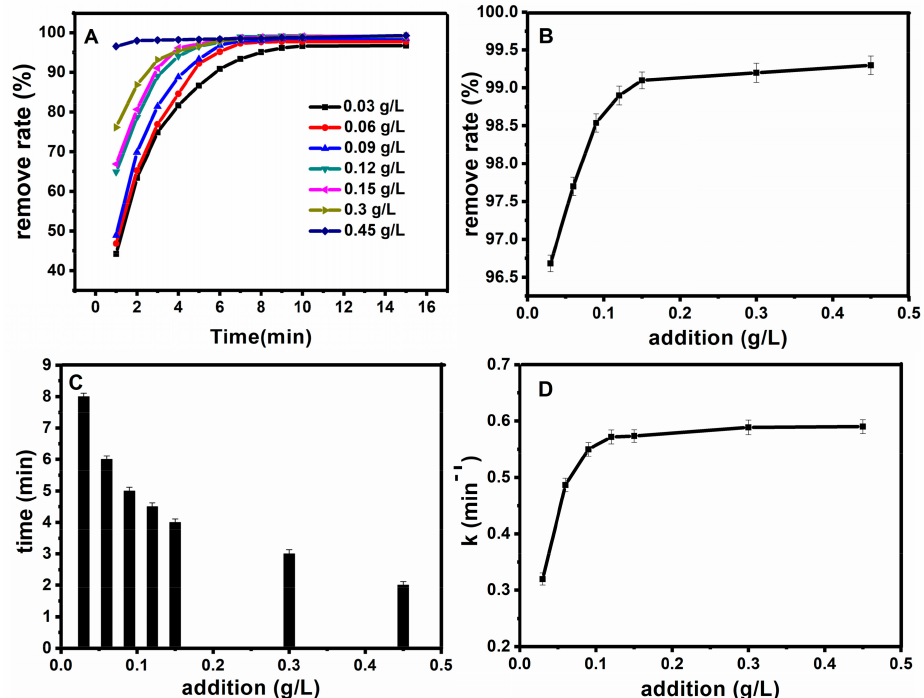
Figure 8. Effect of catalyst dosage on oxidation rate ( A ); the relationship between the catalyst dosage and the removal degree after half an hour ( B ); the relationship between the catalyst dosage and time when the removal degree reached 98% ( C ); the relationship between the catalyst dosage and the work rate ( D